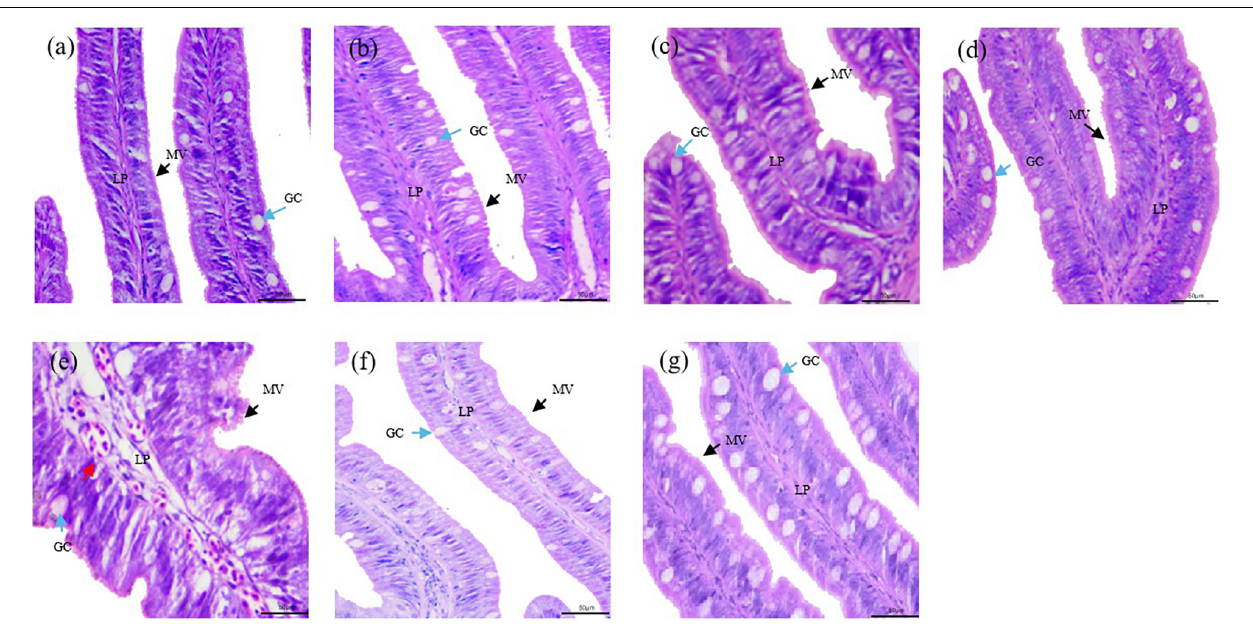
FIGURE 2 | Histological changes of the distal intestine section from turbot in the 7S&FM group at the zeroth day (a) , the third day (b) , the first week (c) , the second week (d) , the third week (e) , the sixth week (f) , and the 10th week (g) . MV, microvilli (black arrows); GC, goblet cells (blue arrows); infiltration of mixed leukocytes (red arrows); LP, lamina propria. Scale bar, 50 µ m. Staining: H&E.